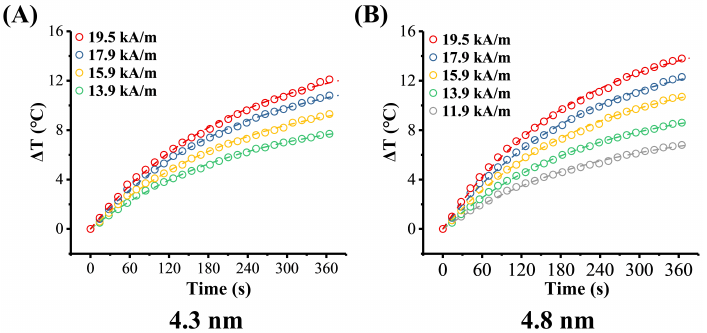
Figure 8. Magnetic field amplitude dependence on heating e ffi ciency of 4.3 nm ( A ) and 4.8 nm ( B ) MHFn nanoparticle samples at 5 mg[Fe] / mL. All the measurements were performed at 805.5 kHz. Dotted lines are the fitting results of Box-Lucas equation.